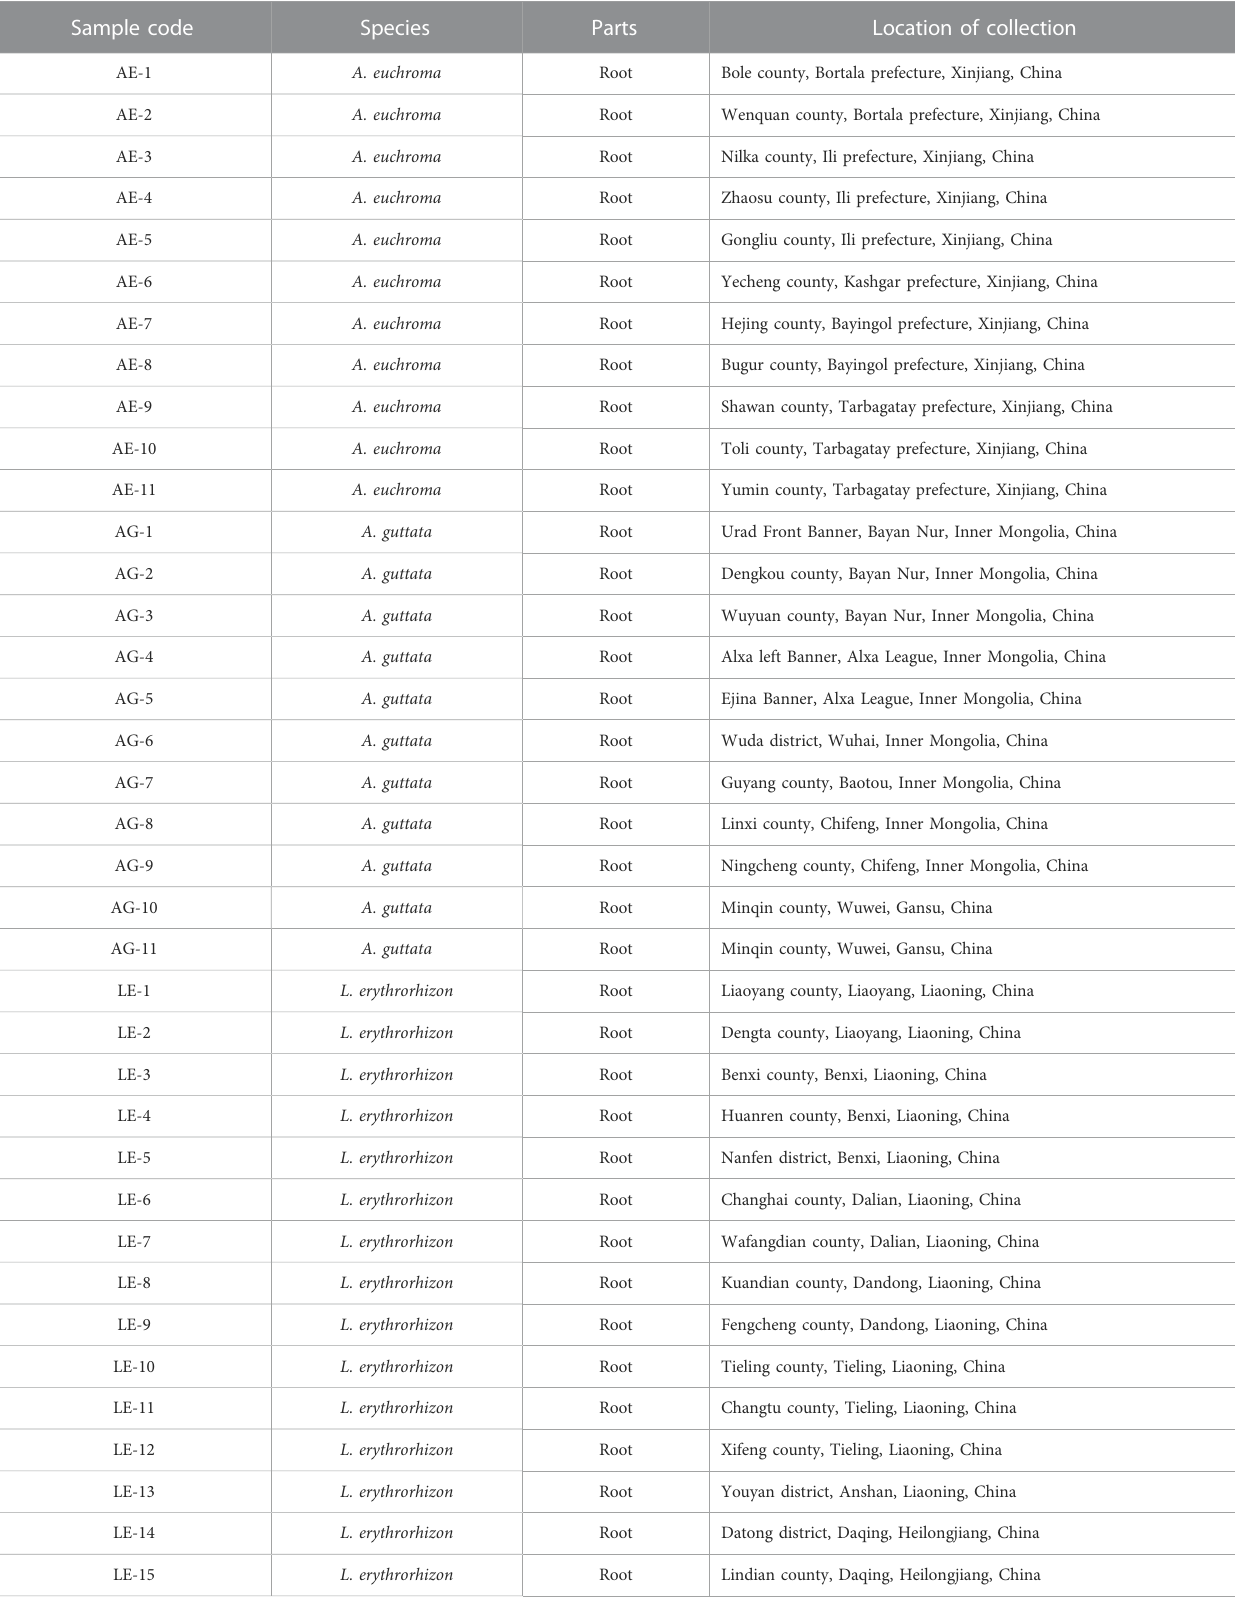
TABLE 1 Sample information. Sample